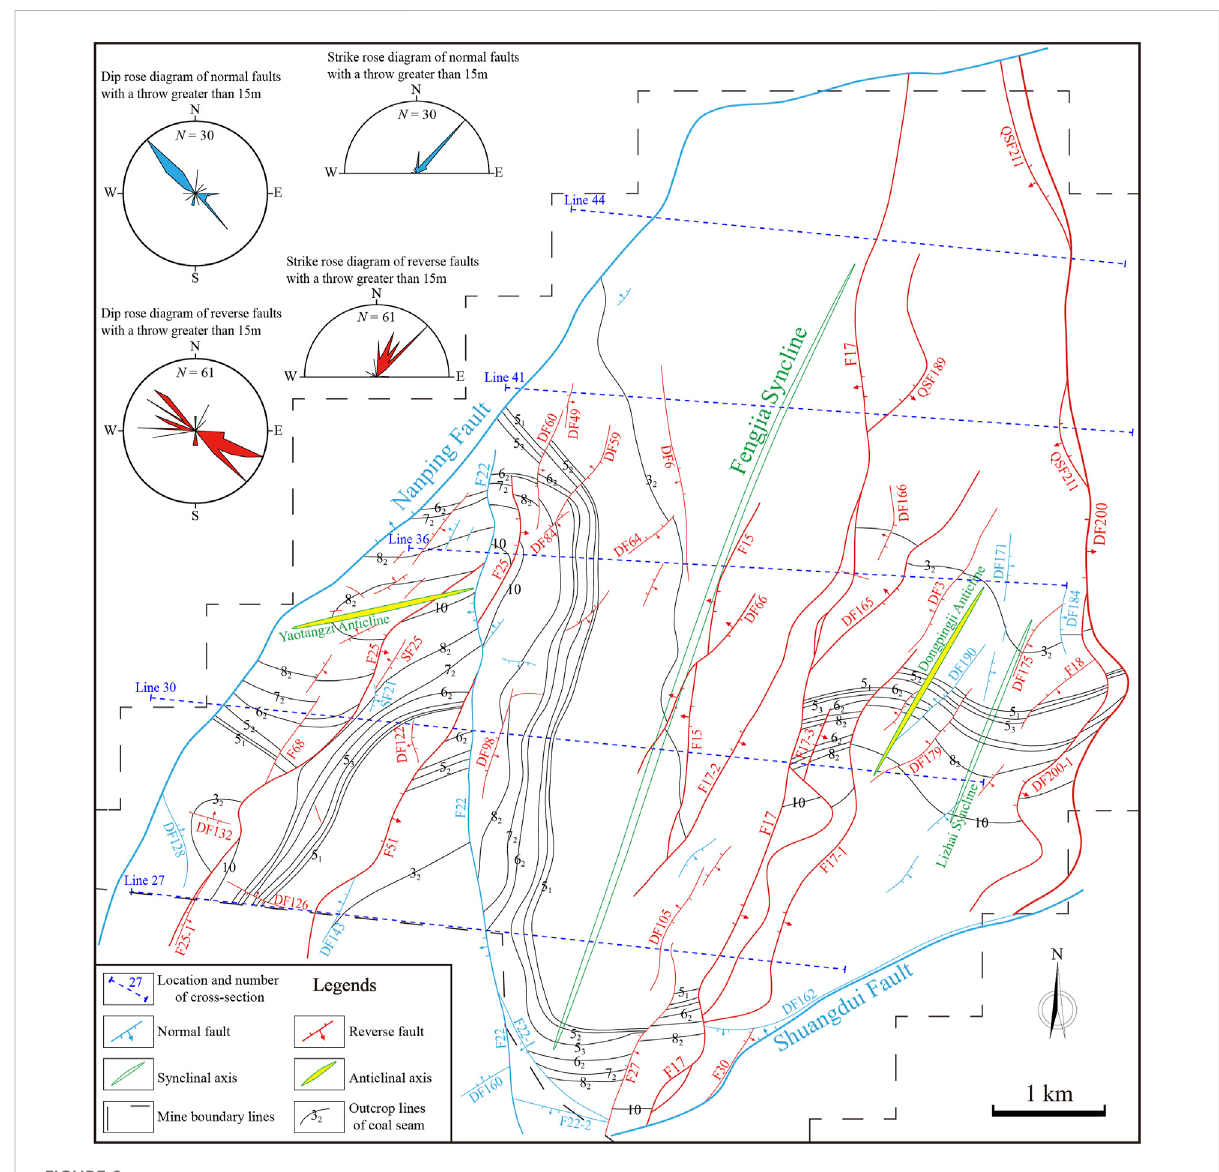
FIGURE 2 Structural outline map interpreted from -650 m horizontal seismic section of the Qianyingzi Coal Mine.